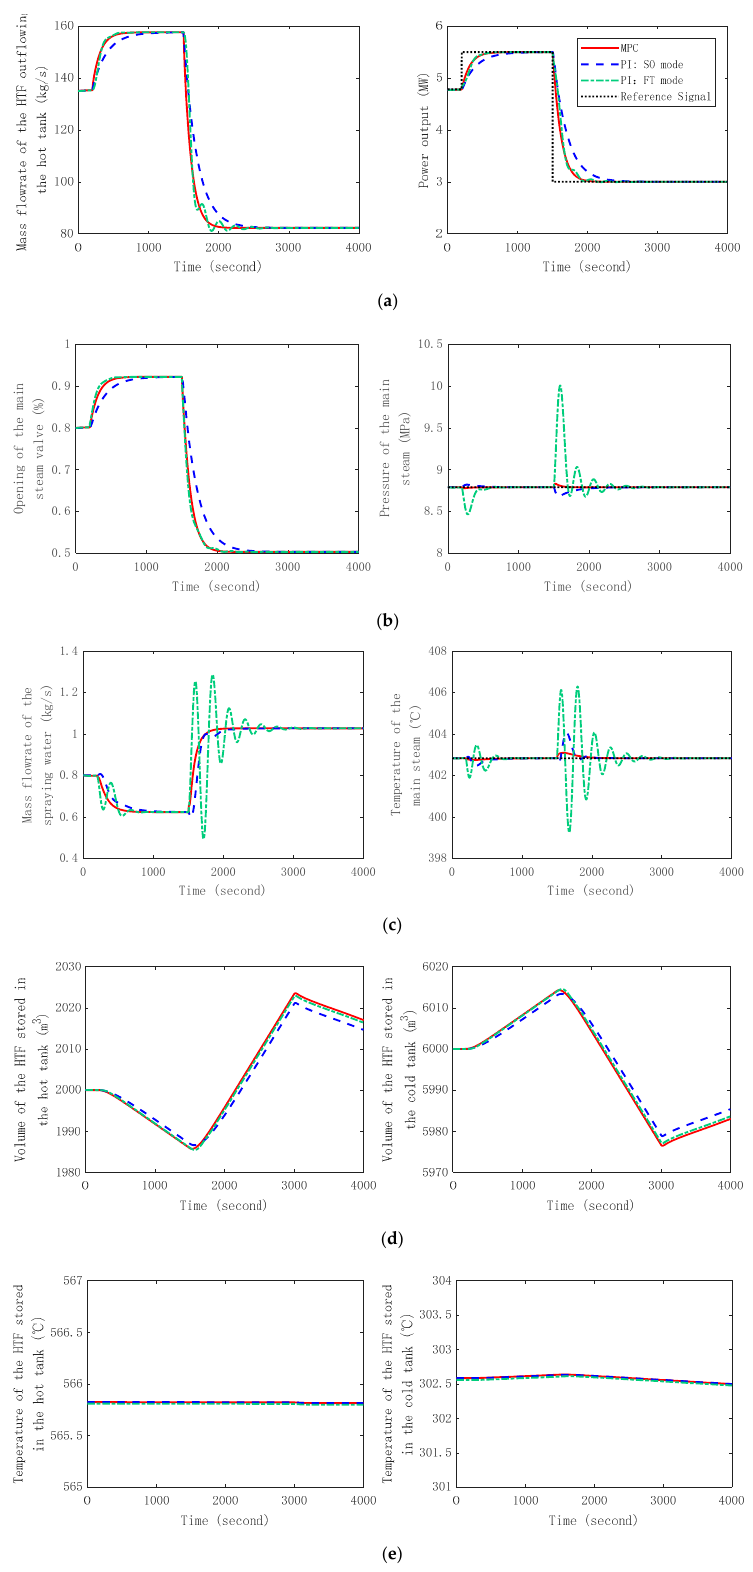
Figure 4. Simulation results of the control system (the legend on the top right side is applied to all the pictures in Figure 4). ( a ) Manipulating variable u 1 and controlled variable y 1 ; ( b ) manipulating variable u 2 and controlled variable y 2 ; ( c ) manipulating variable u 3 and controlled variable y 3 ; ( d ) HTF stored in the hot tank and HTF stored in the cold tank; ( e ) HTF temperature in the hot tank and HTF temperature in the cold